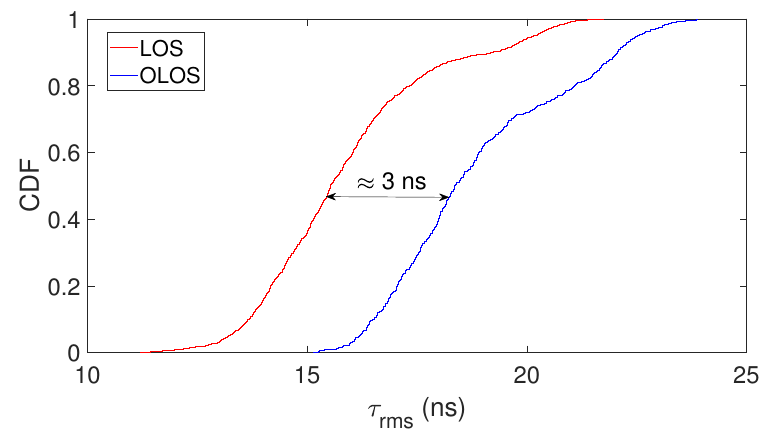
Figure 8. CDF of τ rms for the LOS and OLOS scenarios. Table 4. Minimum, mean, maximum, and STD values of τ rms (in ns) and B C ,90% (in